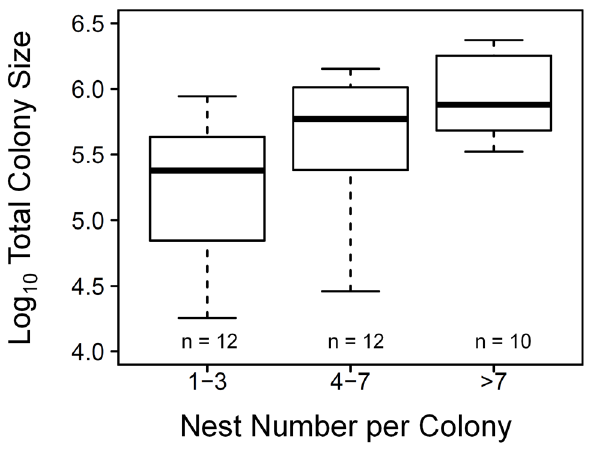
Fig. 5. The relationship between number of nests and total colony size. Kruskal-Wallis’ test, x 2 5 10.15, P , 0.01.